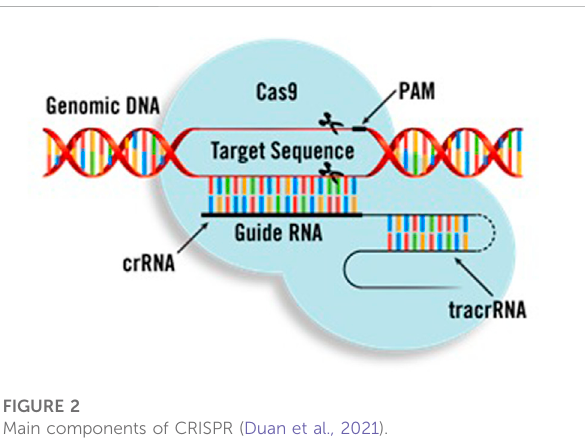
FIGURE 2 Main components of CRISPR (Duan et al., 2021).